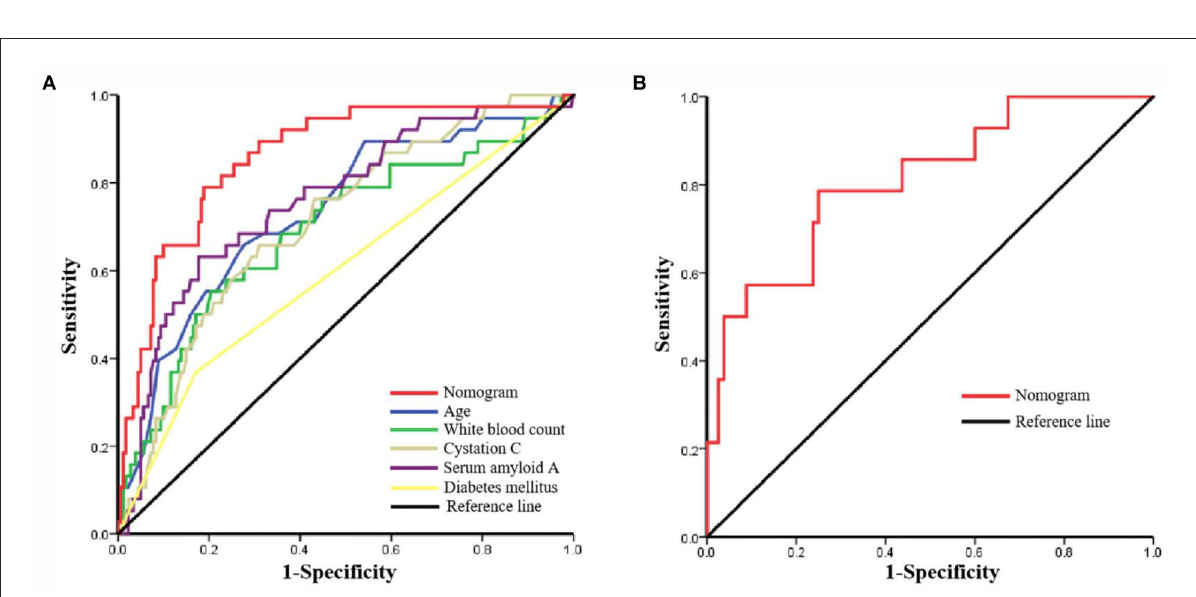
FIGURE4 The receiver operating characteristic (ROC) curve of the nomogram in the training set and the validation set. (A) ROC in the training set; (B) ROC in the validation set.